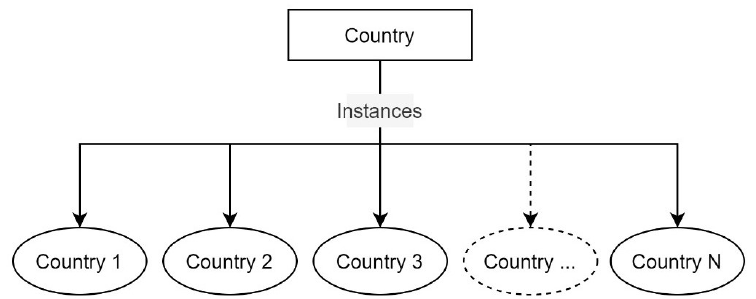
Figure 1. Taxonomy for the Country class.